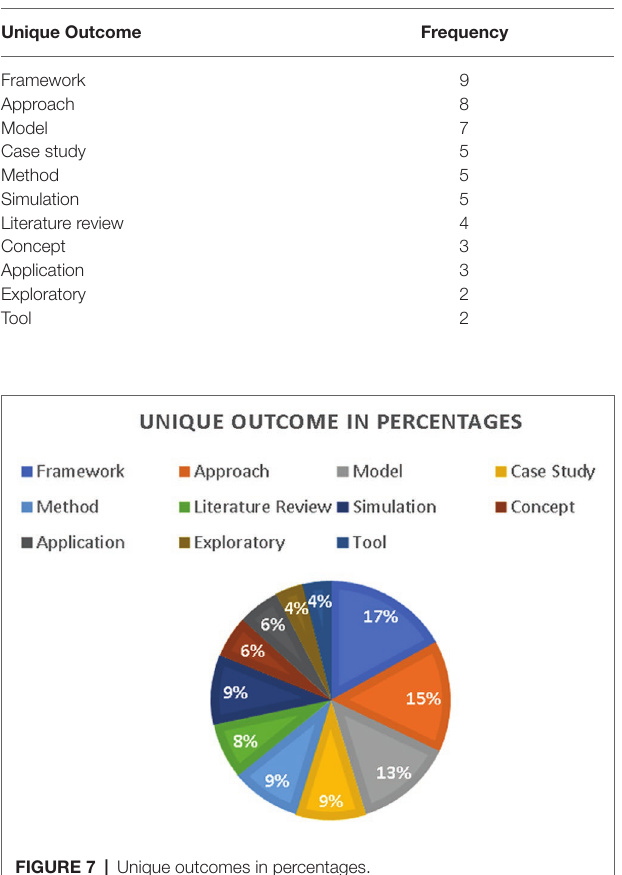
FIGURE 7 | Unique outcomes in